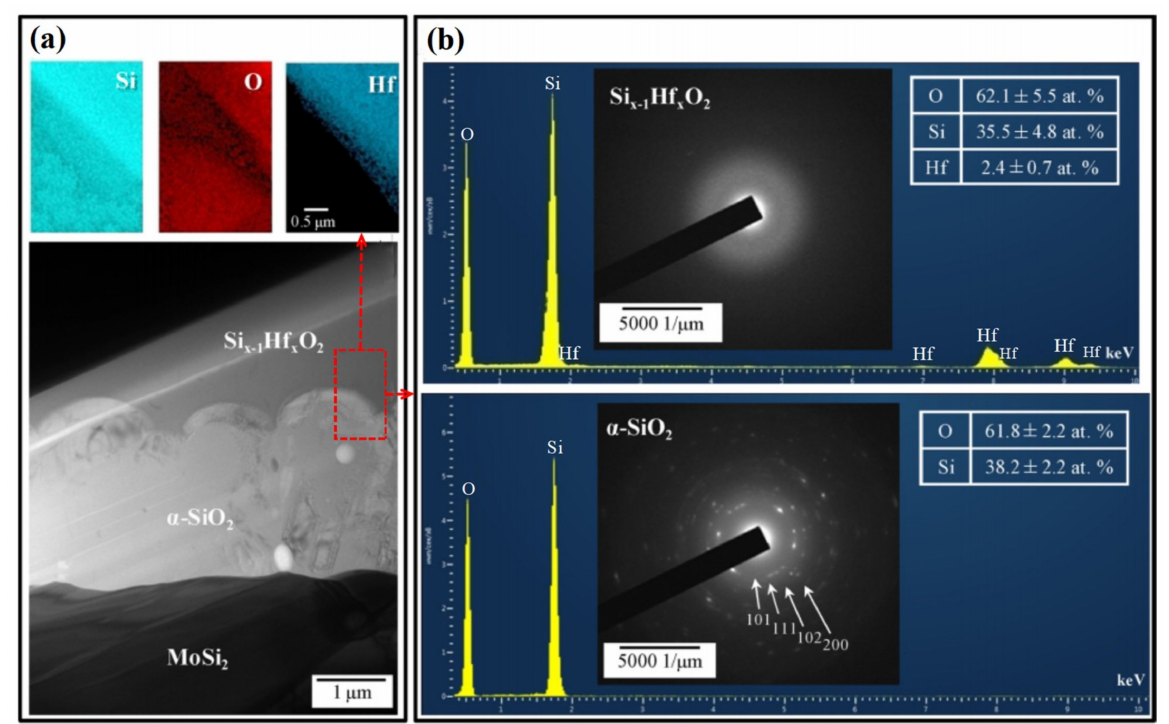
Figure 5. ( a ) TEM micrograph of the oxidized X34 1 sample; ( b ) EDS and diffraction patterns of the oxide scale. Reproduced with permission [96]. Copyright 2019